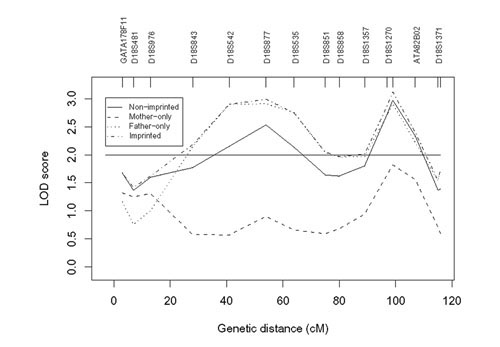
Chromosome 18 LOD scores with sex-specific maps LOD scores at each marker have been joined to produce continuous curves. Map distances on X-axis are from the sex-averaged map.